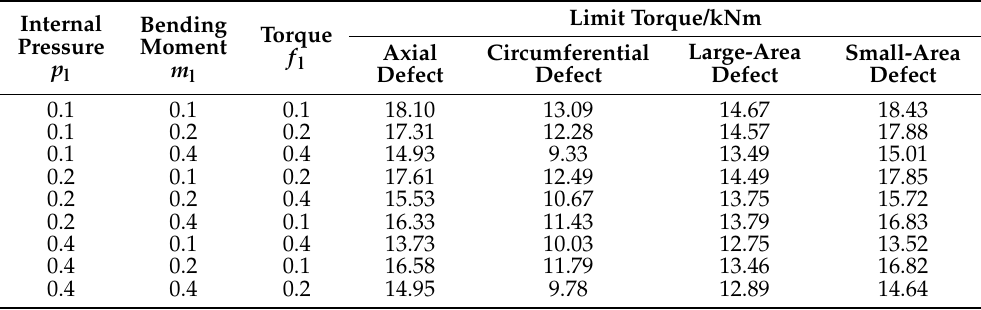
Figure 7. The load vs. plastic strain curves of a straight pipe with a local wall-thinning defect under complex loads: ( a ) internal pressure; ( b ) bending moment; ( c ) torque; ( d ) axial force. Table 9. The calculation results of the limit load of straight pipes with local wall-thinning defects under complex